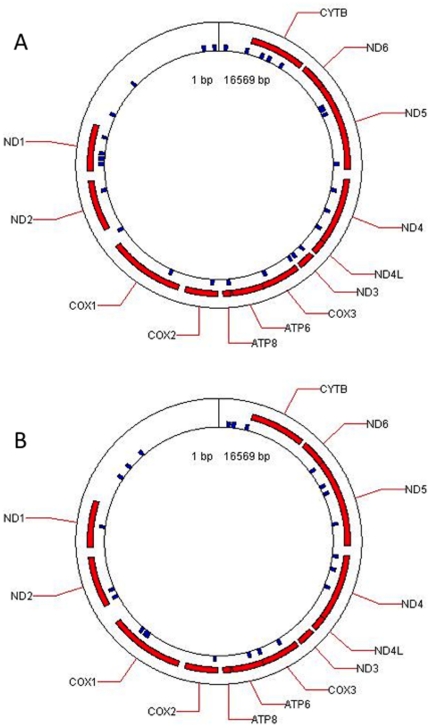
Mitochondrial map of the human pre-mature (A) and mature miRNA (B) candidates identified by alignements between the reference mitochondrial sequence and miRBase data.(A) The locations of the human pre-miRNA described in Table 3 are represented as blue squares on the mitochondrial genome. (B) The locations of the human mature miRNA described in Table 4 are represented as blue squares on the mitochondrial genome.